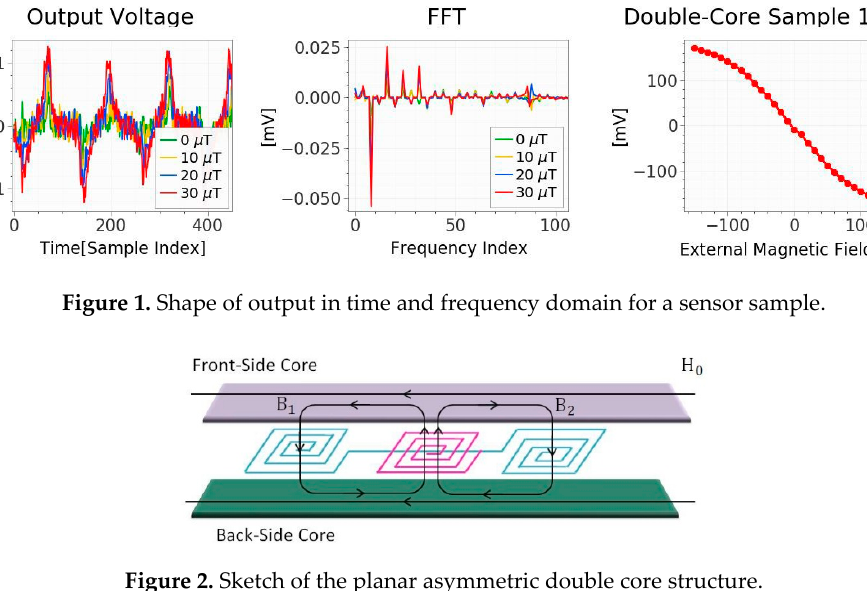
Figure 2. Sketch of the planar asymmetric double core